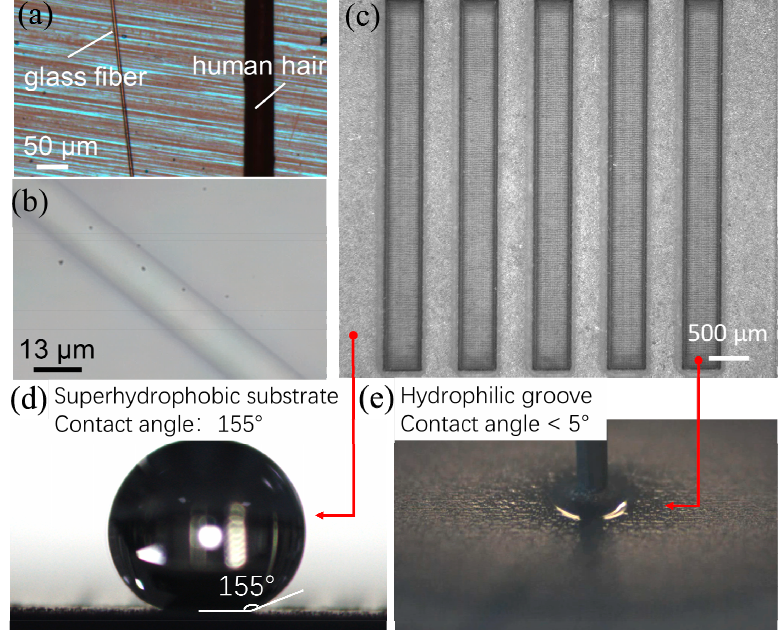
Figure 2. Glass fiber and grooved silicon substrate: ( a ) Microscopic view of a glass fiber next to a human hair; ( b ) Microscopic view of glass fiber with a diameter of 13 µ m; ( c ) Hydrophilic–superhydrophobic patterned substrate with five parallel grooves; ( d ) Contact angle of water on the superhydrophobic substrate; ( e ) Contact angle of water in the hydrophilic